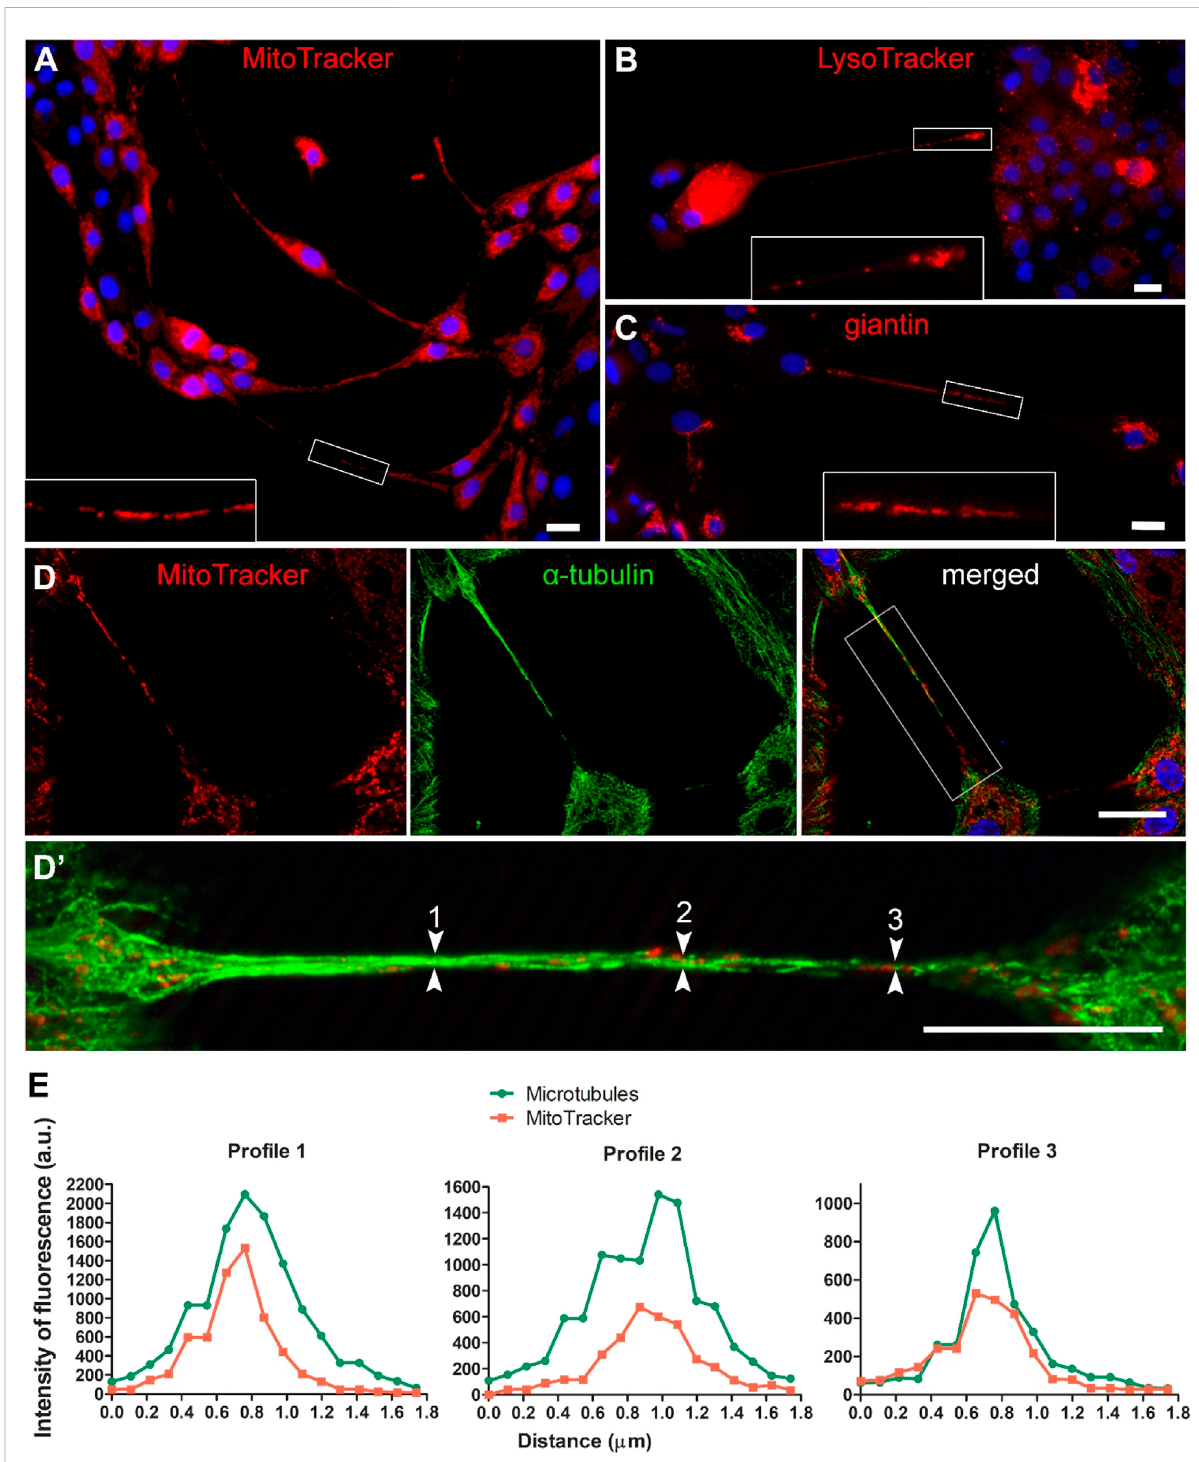
FIGURE 7 Mitochondria,lysosomesandGolgiapparatusinTNTsofnormal(NPU)urothelialcells.Distributionofmitochondria( A , D , D ’ ),lysosomes (B) ,and Golgiapparatus (C) inTNTs.ThelargeinsetsinA,B,Care300%magni fi cationsofthecorrespondingsmallinsets. (D) Thedistributionofmitochondria and microtubules in TNTs, enlarged in ( D ’ ). Numbers 1, 2, and 3 (arrows) denote cross sections in TNT where pro fi les of fl uorescence intensities of microtubules and MitoTracker were measured (E) . Data is presented as intensity of fl uorescence (arbitrary units a. u.) per 1.8 μ m cross section. Scale bars: 20 μ